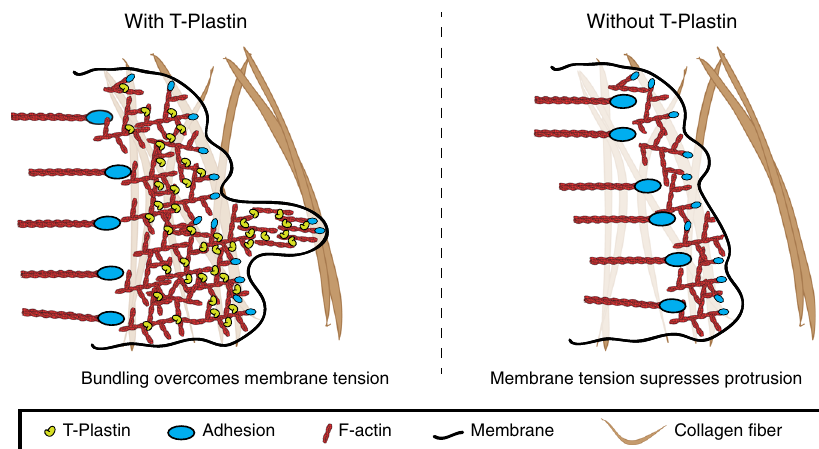
Fig. 8 Model of how T-Plastin promotes ECM gap bridging. Left, T-Plastin strengthens and extends the protrusive actin network between nascent adhesions at the leading edge and mature focal adhesions further back in the lamellum. This reinforcement facilitates a cell ’ s ability to protrude across gaps in the ECM. Right, in the absence of T-Plastin cells are unable to overcome the opposing force of membrane tension, the protrusive actin network becomes reduced in size, and cells exhibit an inability to protrude across ECM